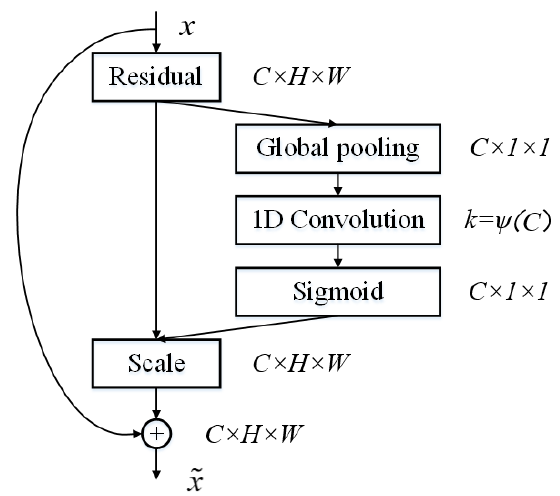
Figure 5. ECA-Net attention mechanism Figure 5. ECA-Net a tt ention mechanism module.